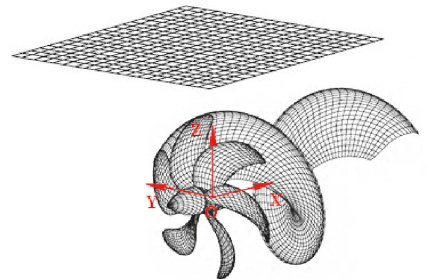
Figure 6: Propeller and plate for verification.